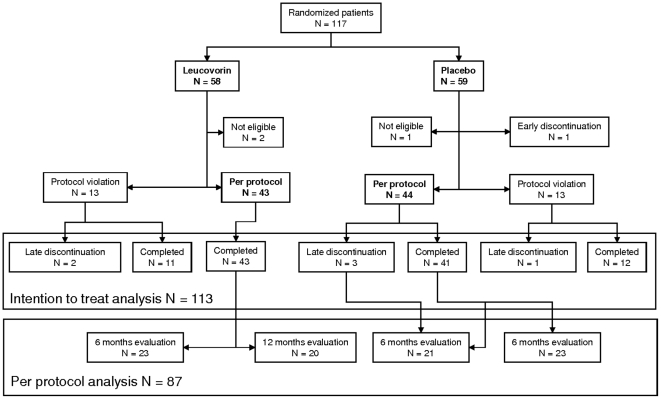
Flow chart of participants in the clinical trial.N = number of patients. Not eligible: patients with no efficacy and safety data after V1. Early premature V1 discontinuation: patients with no efficacy and safety data after V1. Late premature V2 discontinuation: patients not evaluated after V2 (6 months). Per protocol analysis: patients assessed by the same psychometric examiner during at least 2 visits. Major protocol violation: patients not assessed by the same psychometric examiner at 2 consecutive visits. Completed: patients without protocol violation and with 12 months of efficacy and safety data.